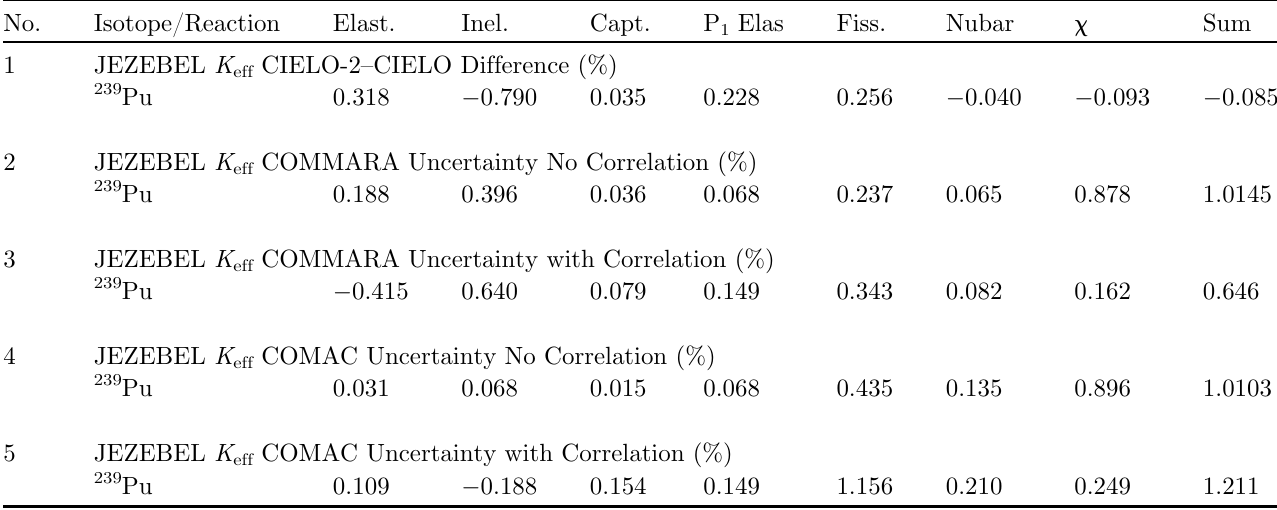
Table 2. (C-E)/E of CIELO and CIELO-2 239 Pu and consistency with uncertainty of COMMARA 2.0 and COMACV1: JEZEBEL.